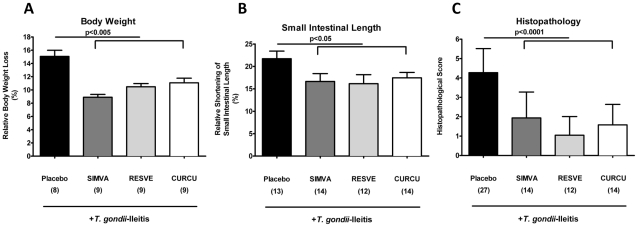
Less small intestinal immunopathology after treatment with Simvastain, Resveratrol or Curcumin (8 days after T. gondii infection).(A) Relative body weight loss of mice after treatment with Placebo (n = 8), Simvastain (SIMVA; n = 9), Resveratrol (RESVE; n = 9) or Curcumin (CURCU; n = 9) from d-2 until d8 p.i. (B) Relative small intestinal shortening of mice after treatment with Placebo (n = 13), Simvastain (SIMVA; n = 14), Resveratrol (RESVE; n = 12) or Curcumin (CURCU; n = 14) from d-2 until d8 p.i. (C) Histopathology of the terminal ileum of mice treated with Placebo (n = 27), Simvastain (SIMVA; n = 14), Resveratrol (RESVE; n = 12) or Curcumin (CURCU; n = 14) from d-2 until d8 p.i.. Mean values, standard deviations, and significance levels as indicated were determined by the Student's t test. Data are pooled from at least three independent experiments.